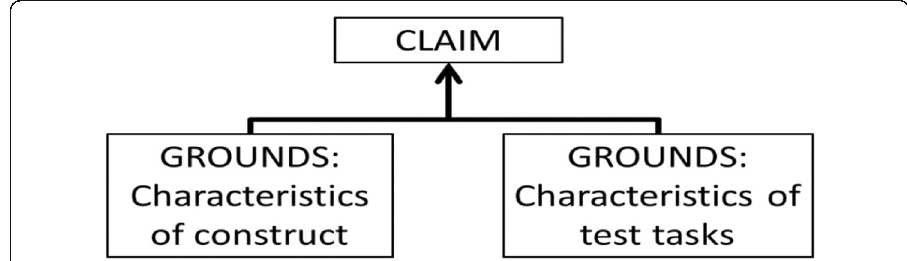
Fig. 4 An adaptation of the Chapelle et al. (2008) dual grounds for iBT TOEFL® inference from Schwabe et al. (2016)